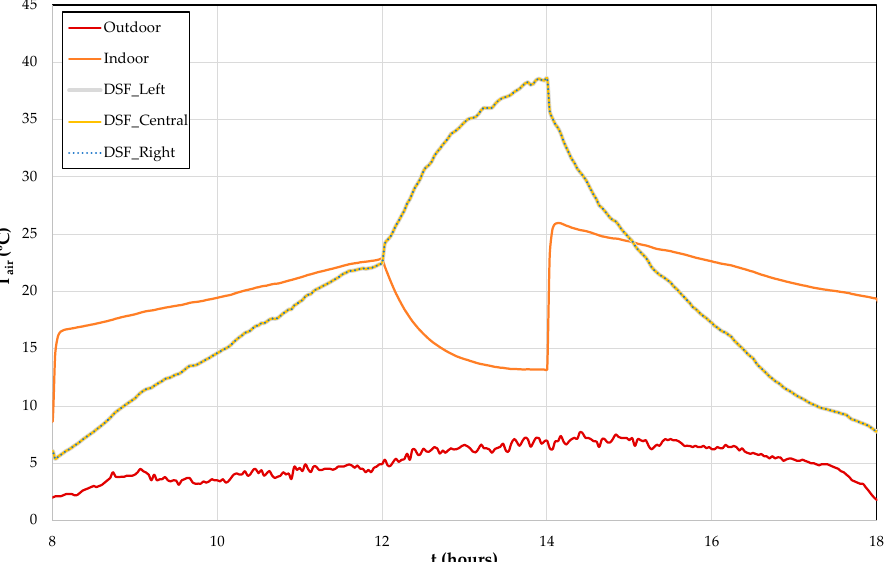
Figure 13. Evaluation of air temperature (T air ) of the outdoor environment, indoor virtual chamber and indoor left, central and right DSF system, when the airflow rate is constant and the number of DSFs to operate is variable, for the Case A.